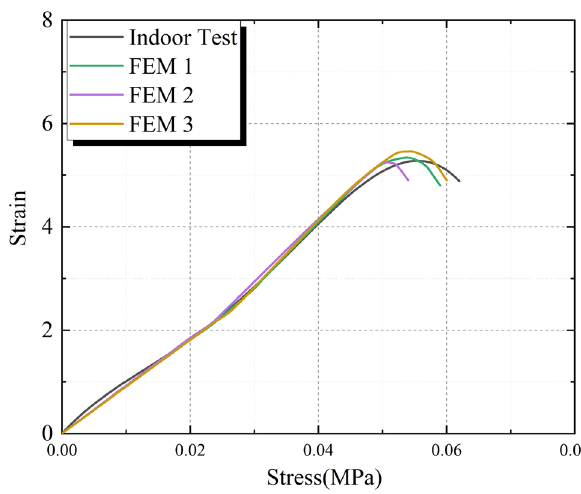
Figure 10: Comparison of stress – strain curves.